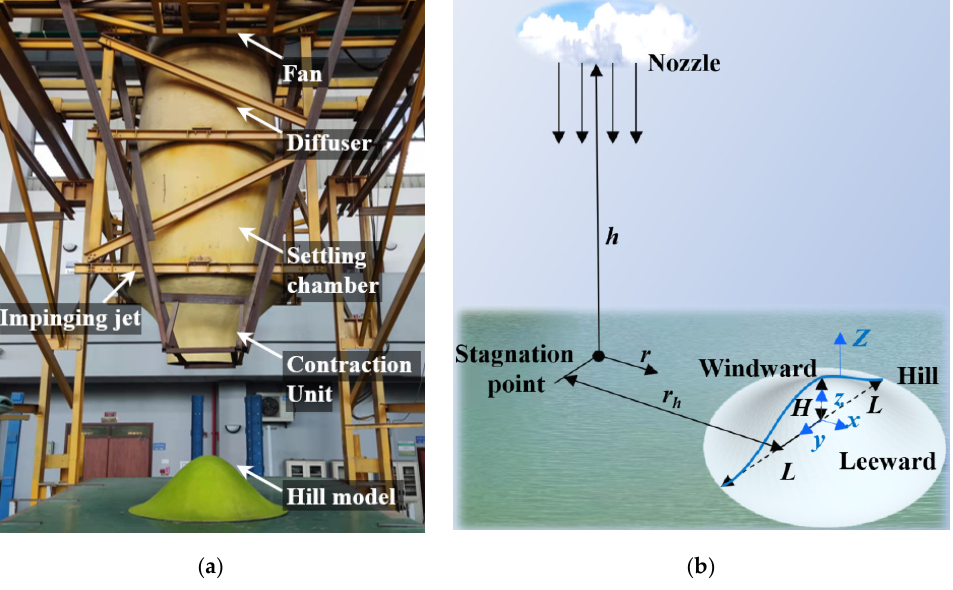
Figure 2. Experimental setup ( a ) and coordinate systems ( b ). Table 2. Dimensions of hill models.